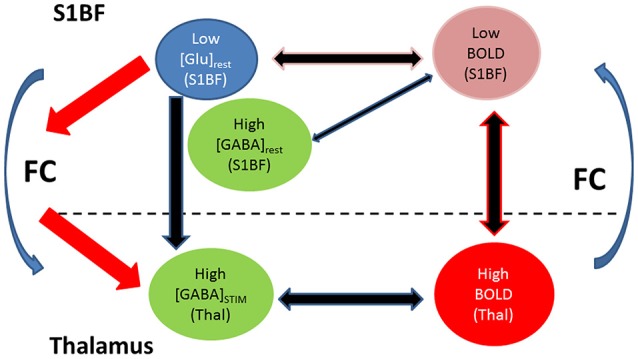
Preliminary schematical overview of the Glutamate and GABA modulatory effects and functional connectivity on cortico-thalamo cortical loop in a healthy rat with low BOLD in S1BF (1–2%) under prolonged trigeminal nerve electrical stimulation. Multi-regional investigations during brain activity may help understanding how neurotransmitters relate to functional neuroimaging signals and functional connectivity. Within each structure BOLD responses were modulated by within structure GABA and/or Glutamate levels. In the thalamus, BOLD responses were modulated by GABA during stimulation. These thalamic GABA levels demonstrated strong dependence on resting Glu levels in S1BF. Glutamatergic and GABAergic processes modulate thalamocortical and corticothalamic functional connectivity (FC). We postulate that these processes may involve regulation of neuronal synchrony between thalamus and cortex.